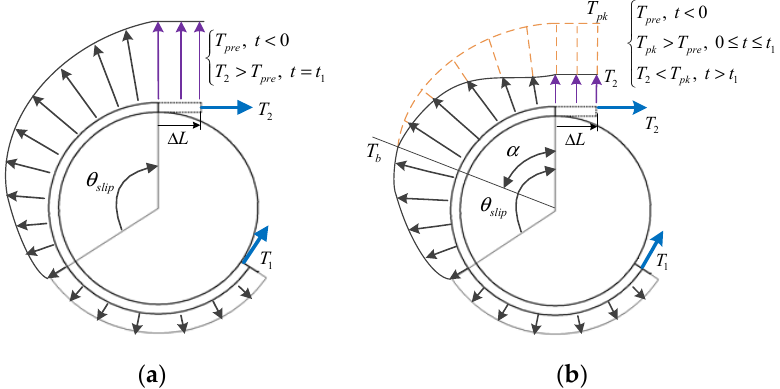
Figure 3. Tension distribution of the cable: ( a ) Tension distribution of the cable under loading; ( b )